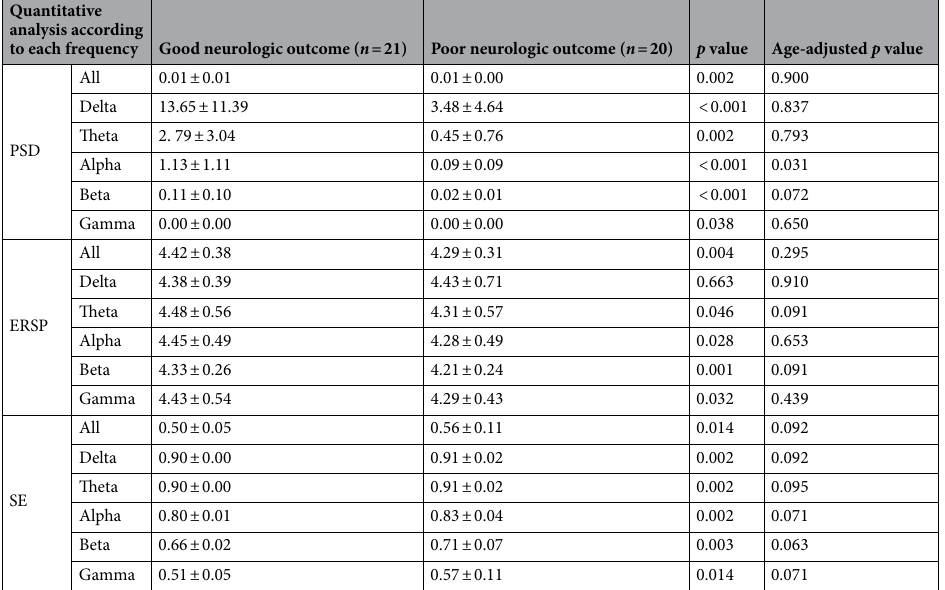
Table 2. Comparisons of quantitative analysis using PSD, ERSP, and SE of each frequency between the out-of-hospital cardiac arrest patients with good and poor neurologic outcomes at 1 month. All frequency, 0.5–100 Hz; delta frequency, 0.5–4 Hz; theta frequency, 5–7 Hz; alpha frequency, 8–14 Hz; beta frequency, 15–30 Hz; and gamma frequency, 31–100 Hz. PSD power spectral density, ERSP event-related spectral perturbation, SE spectral